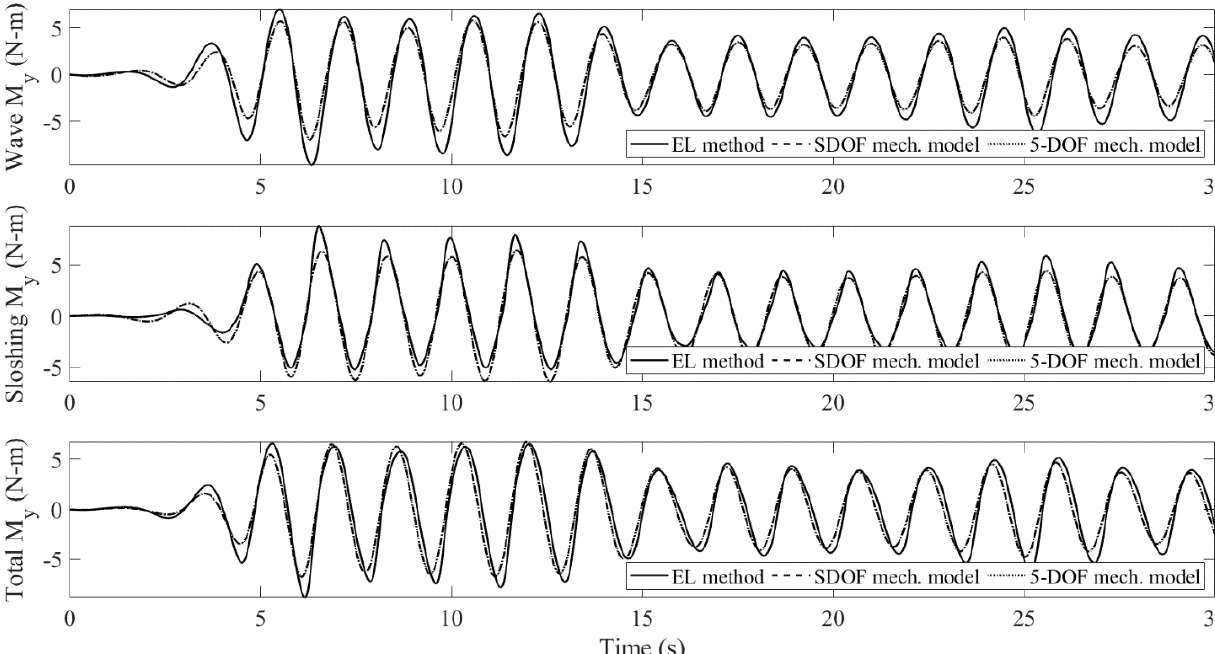
Figure 12. The pitch motion responses of the floating body, configured with a water tank installed with porous media, undergoing large wave excitation.